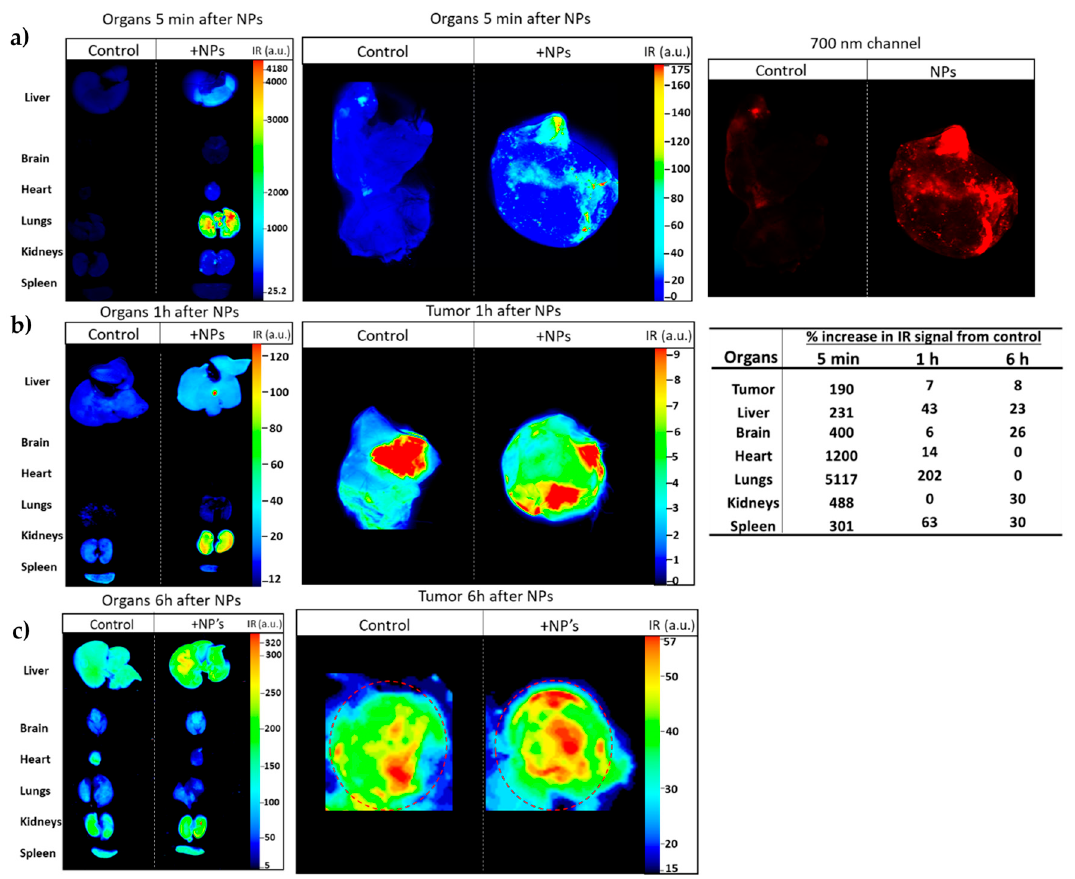
Figure 13. The IR-labeled NP-253 reaches the tumor area in a Lewis Lung Carcinoma mouse model. ( a ) Upper panel left and middle images show in multicolor the 700 nm signal intensity (heat map of IR signal intensity areas), representing NP-253 distribution in mouse tumor and organs at 5 min after intravenous (i.v.) injection of NP or control PBS (also having IR background signal). The far-right panel shows the infrared signal from the NPs in the tumor 5 min after i.v. injection only with the red channel (for clarity of NPs distribution in tumor). ( b , c ) Middle and lower panels show a heat map of the IR signal from the NPs or PBS control in the tumor 1 and 6 h (respectively). The table on the right shows the percent of IR signal (IR pixels) from the tissues of NP-injected mice over the control mice. Each image represents one mouse, n = 6.